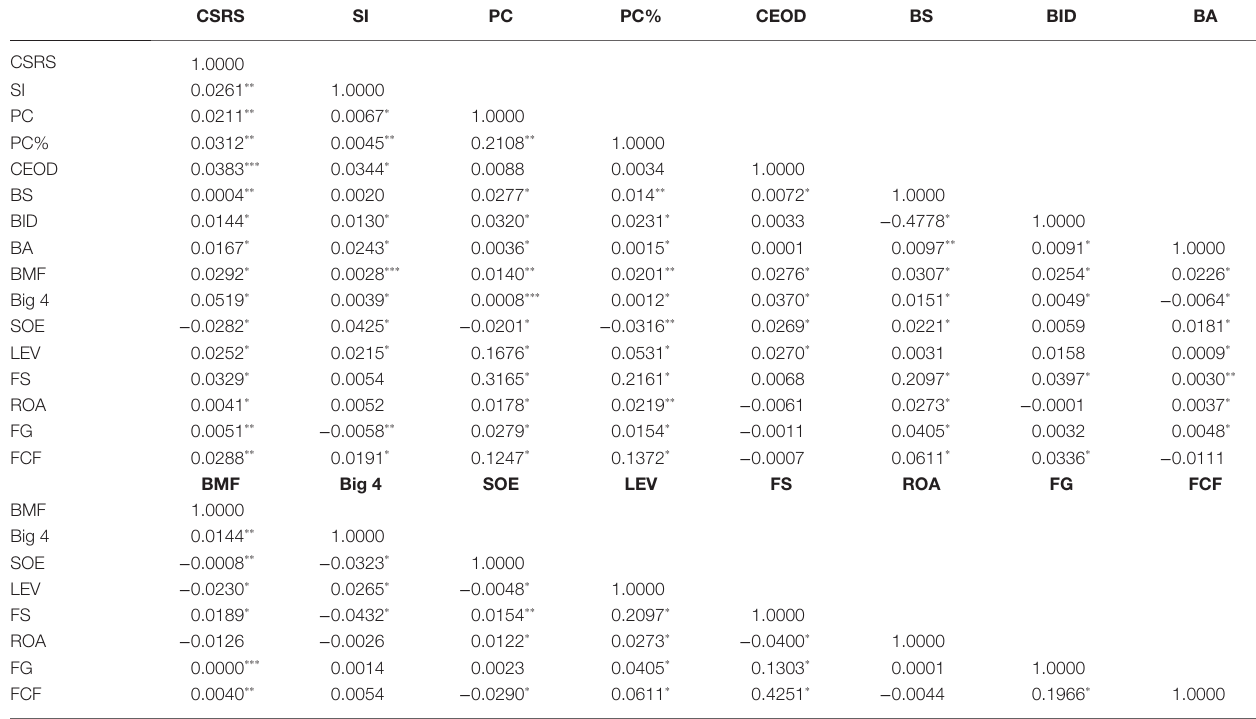
TABLE 3 | Correlation matrix.